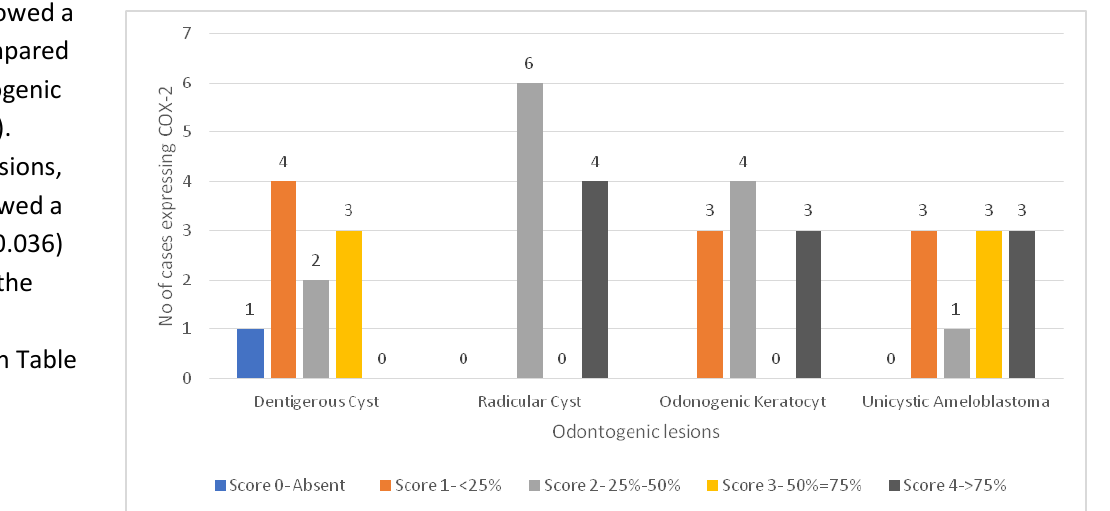
Fig 2. Comparison of the Percentage of COX-2 positive (Score) odontogenic epithelial cells